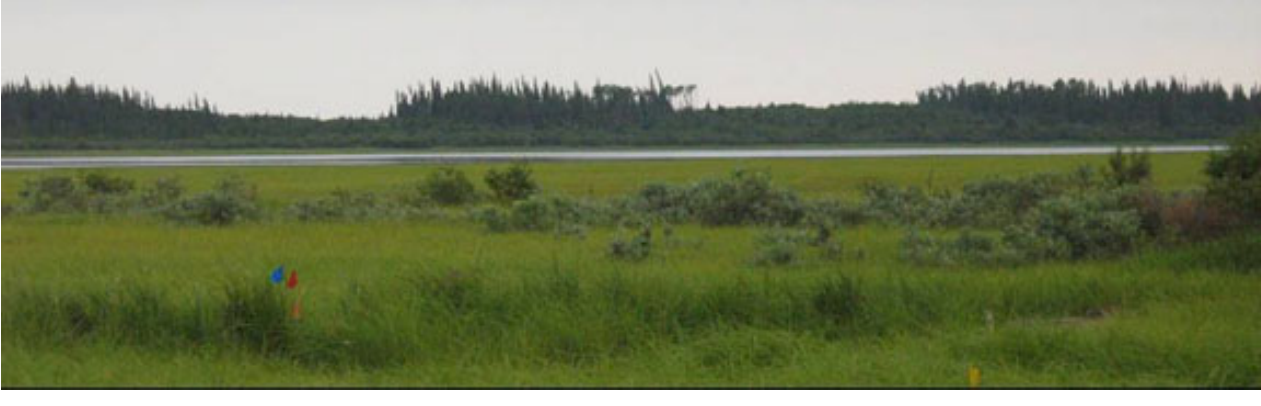
Fig. 4 . Two large tuuhiikaan . The left tuuhiikan is 115 to 150 meters wide and 250 to 300 meters long. The right tuuhiikan is 130 to 230 meters wide and 300 meters long. They were first cut in the early 1980s and were last maintained (re-cut) in 2003 and 2006,